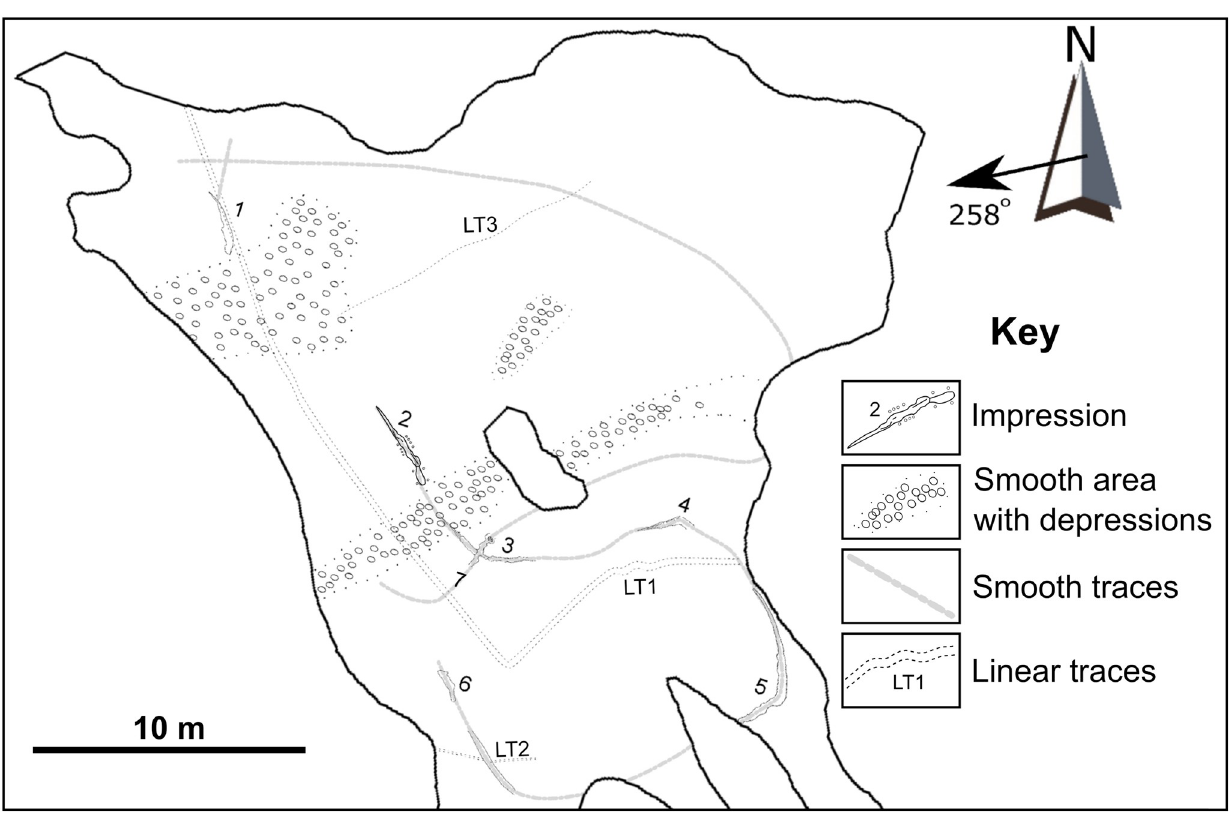
Fig 5. Sketch map of the palaeosurface showing the location of the seven large impressions, smooth areas with subcircular depressions, and linear traces. The palaeocurrent as indicated by the asymmetrical ripples is 258˚. The six large impressions are numbered 1–7 and this scheme is followed in the text and subsequent figures. The linear traces are labeled LT1